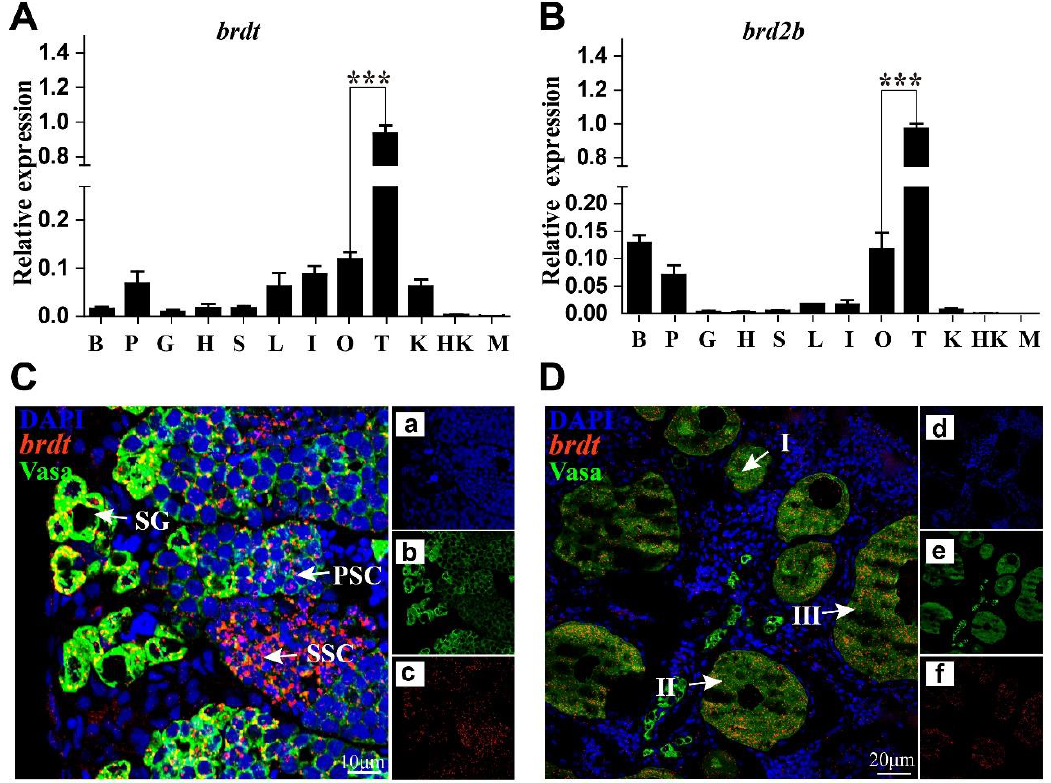
Figure 5. Expression validation and cellular location of BRDs. Expression validation of brdt and brd2b by quantitative real time PCR ( A , B ), and cellular location of brdt by fluorescence in situ hybridization in testis ( C ) and ovary ( D ) at 180 dah. Nuclei were counterstained with DAPI (a,d). Red fluorescence represents the signal of brdt (b,e). Green fluorescence represents the Vasa signals (c,f). gapdh was used as an internal control. Results are presented as mean ± SD. Asterisk above the error bar indicates statistical differences at p < 0.05 as determined by one-way ANOVA followed by Tukey test (* p < 0.05, ** p < 0.01, *** p < 0.001). B, brain; P, pituitary; G, gill; H, heart; S, spleen; L, liver; I, intestinal; O, ovary; T, testis; K, kidney; HK, head kidney; M, muscle; I to III, phase I to III oocytes; SG, spermatogonia; PSC, primary spermatocytes; SSC, secondary spermatocytes. The white arrow indicates co-localization of Vasa and brdt signals.